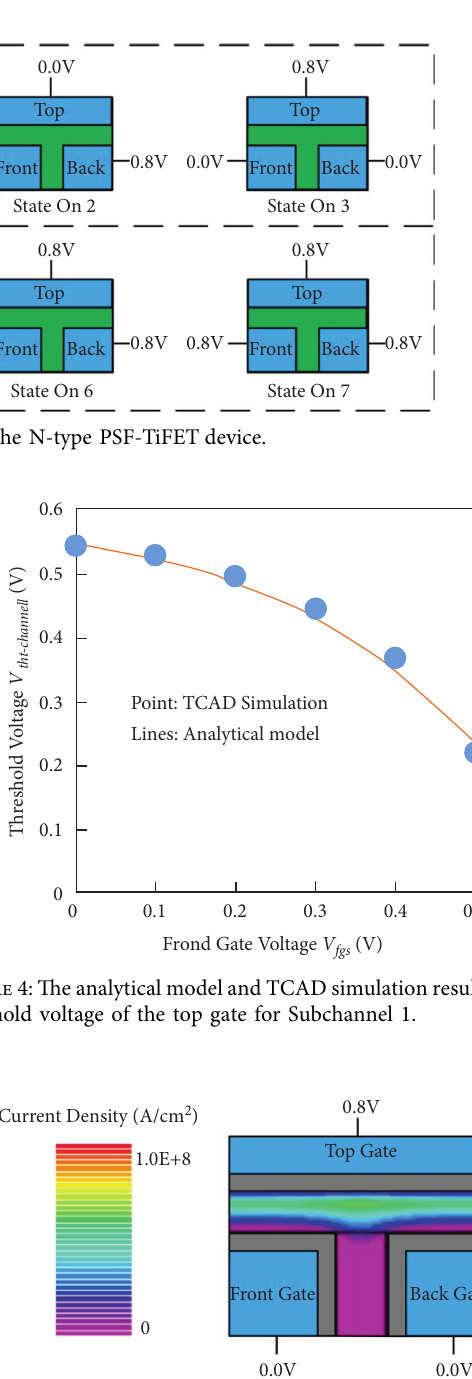
Figure 5: The current density distribution of the PSF-TiFETdevice at V ds � 0.8V when the V tgs is set as 0.8V and both V fgs and V bgs are set as